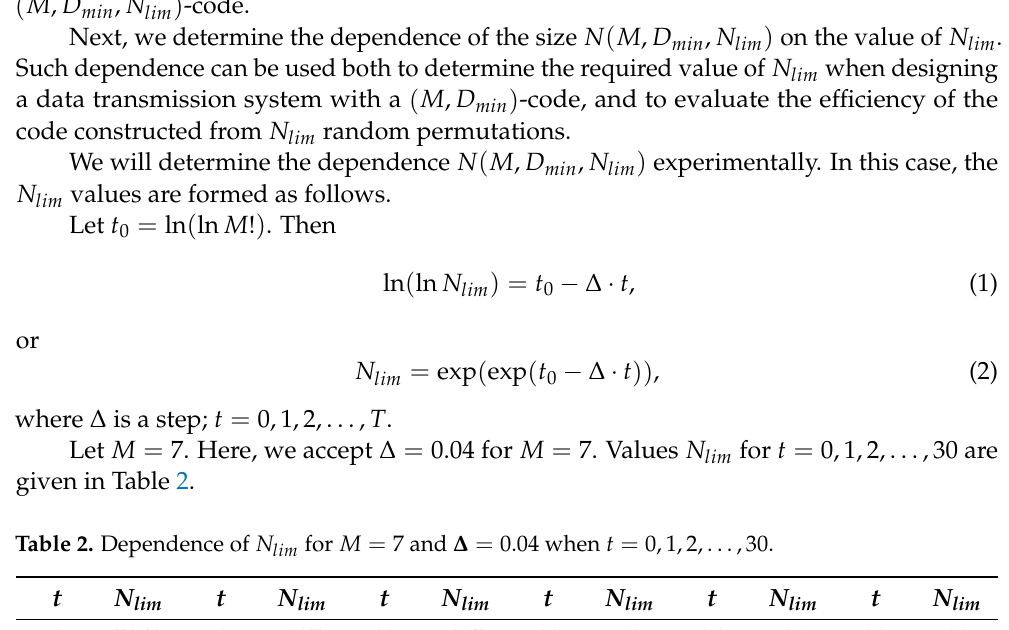
Table 2. Dependence of